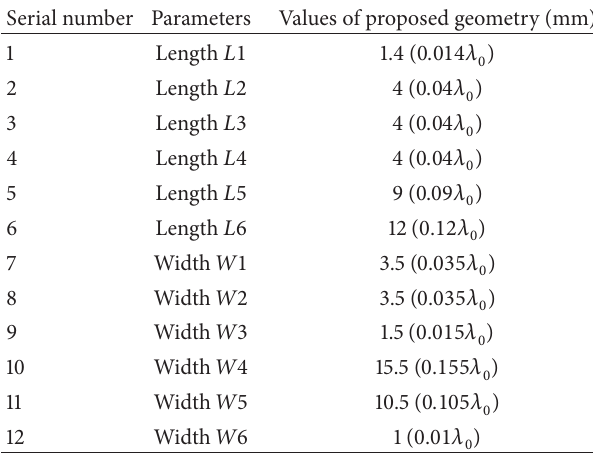
Table 4: Optimal parameter values of the antenna.